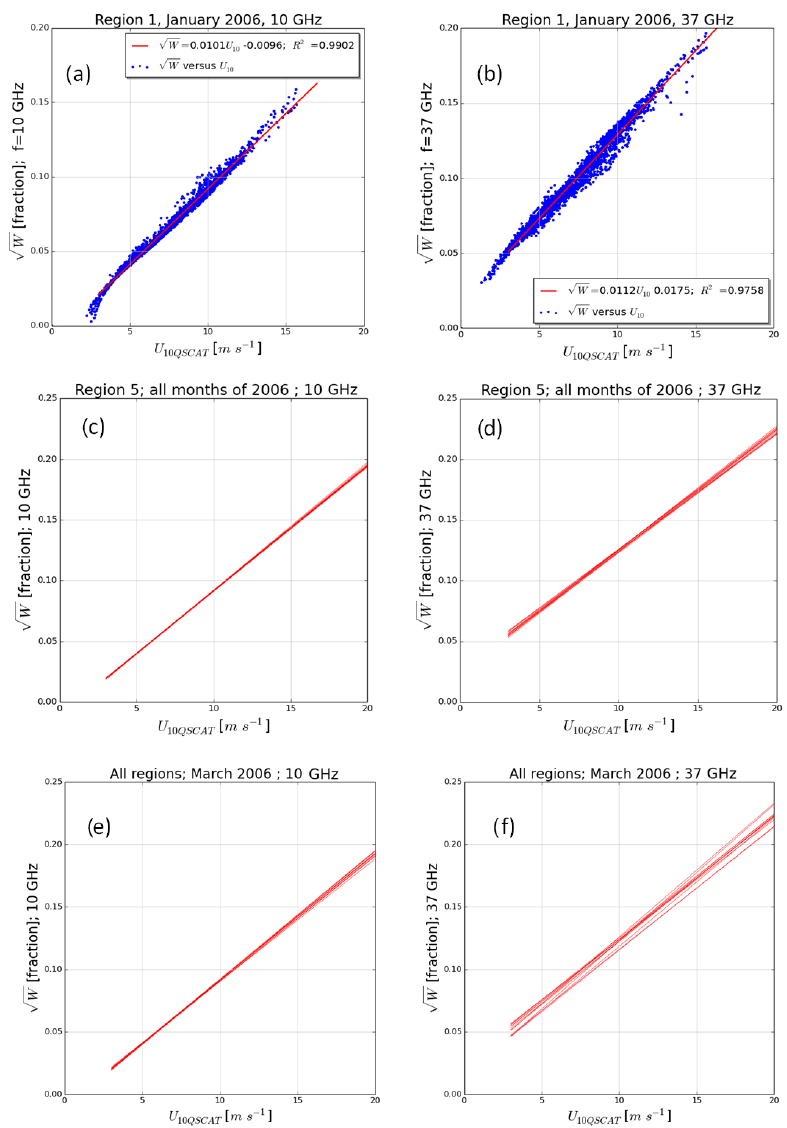
Figure 10. Linear fits of W 1 / 2 vs. U 10 for region 1 for January 2006 at 10GHz (a) and 37GHz (b) ; region 5 for all months of 2006 at 10GHz (c) and 37GHz (d) ; regions 1–12 for March 2006 at 10GHz (e) and 37GHz (f)